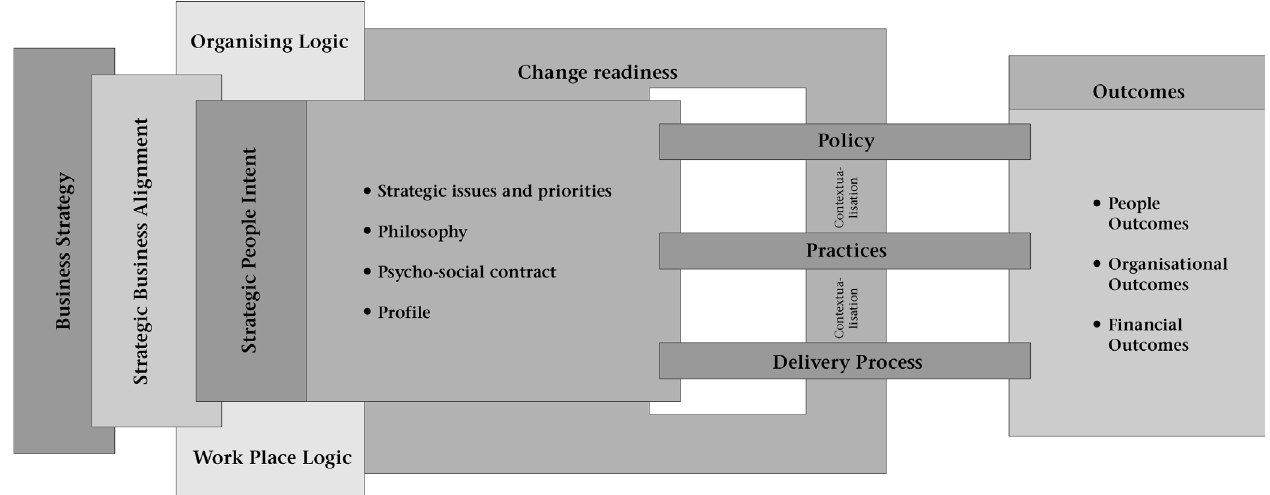
Figure 1: A conceptual model of people management in